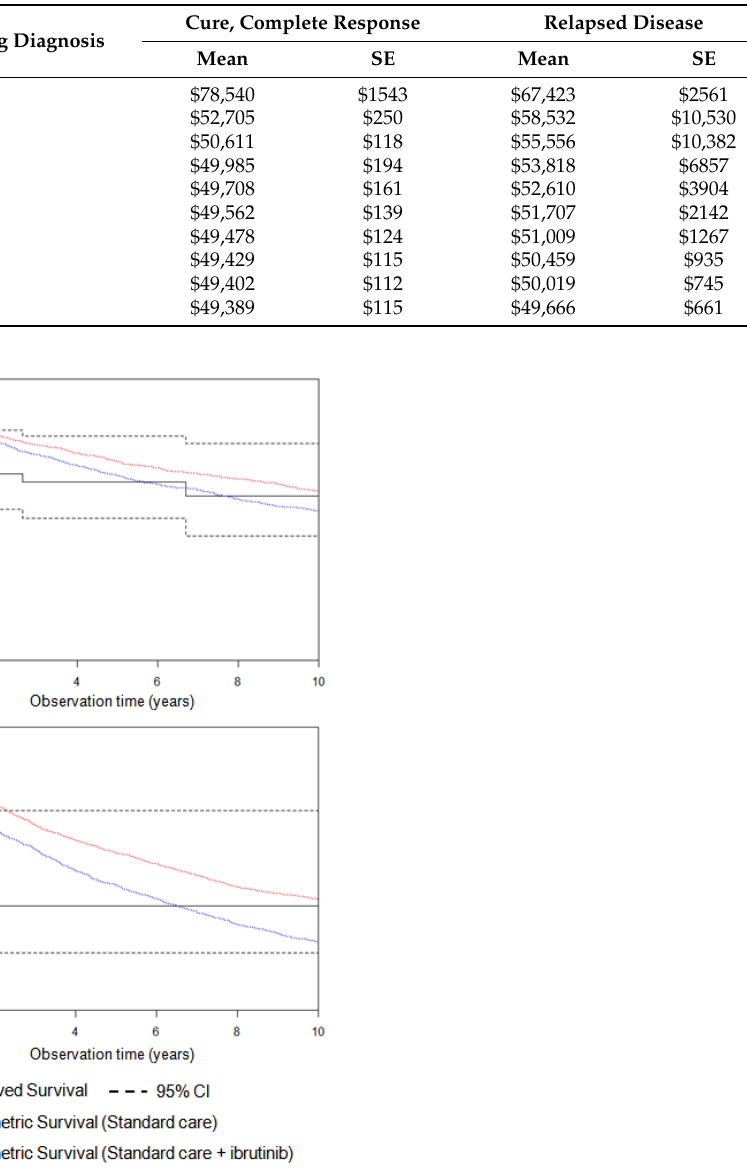
Table A2. Mean Cost of Treatment for Cure, Complete Response and Relapsed Disease Health States (Ibrutinib).